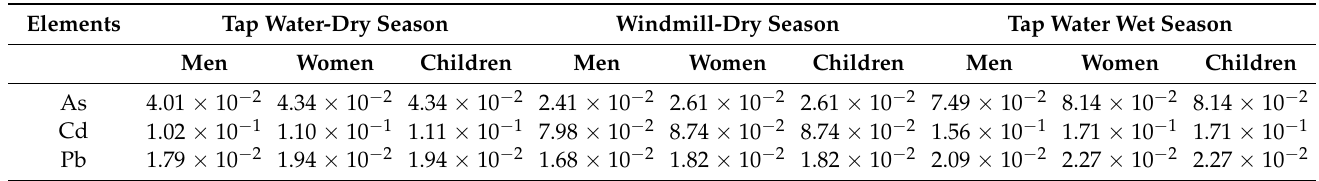
Table 7. Incremental lifetime cancer risk of As, Cd,